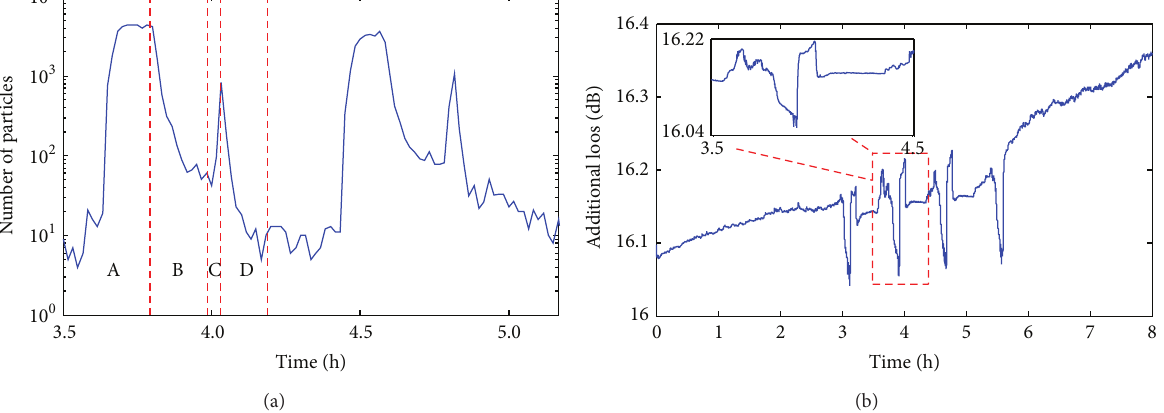
Figure 8: Comparison of experimental results of the sensor and laser-scattering particle counters; (a) the variation of particle numbers measured by laser-scattering particle counters during two periods of flashlamp “Self-Cleaning” test; (b) the additional loss due to the adherence of contaminants dependent on time; the insert shows a period of flashlamp “Self-Cleaning”